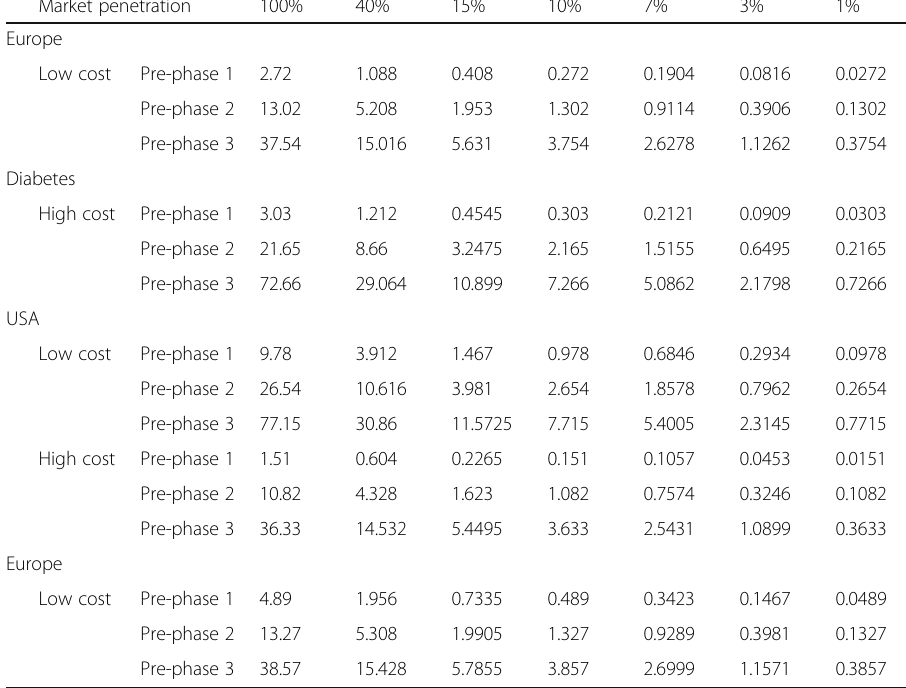
Table 8 SOM rNPVs for each market using real-world data potential market share (numbers in millions of USD) using progress dependent dynamic risk rates (pd-DRR) for valuations (Continued) Market penetration 100%